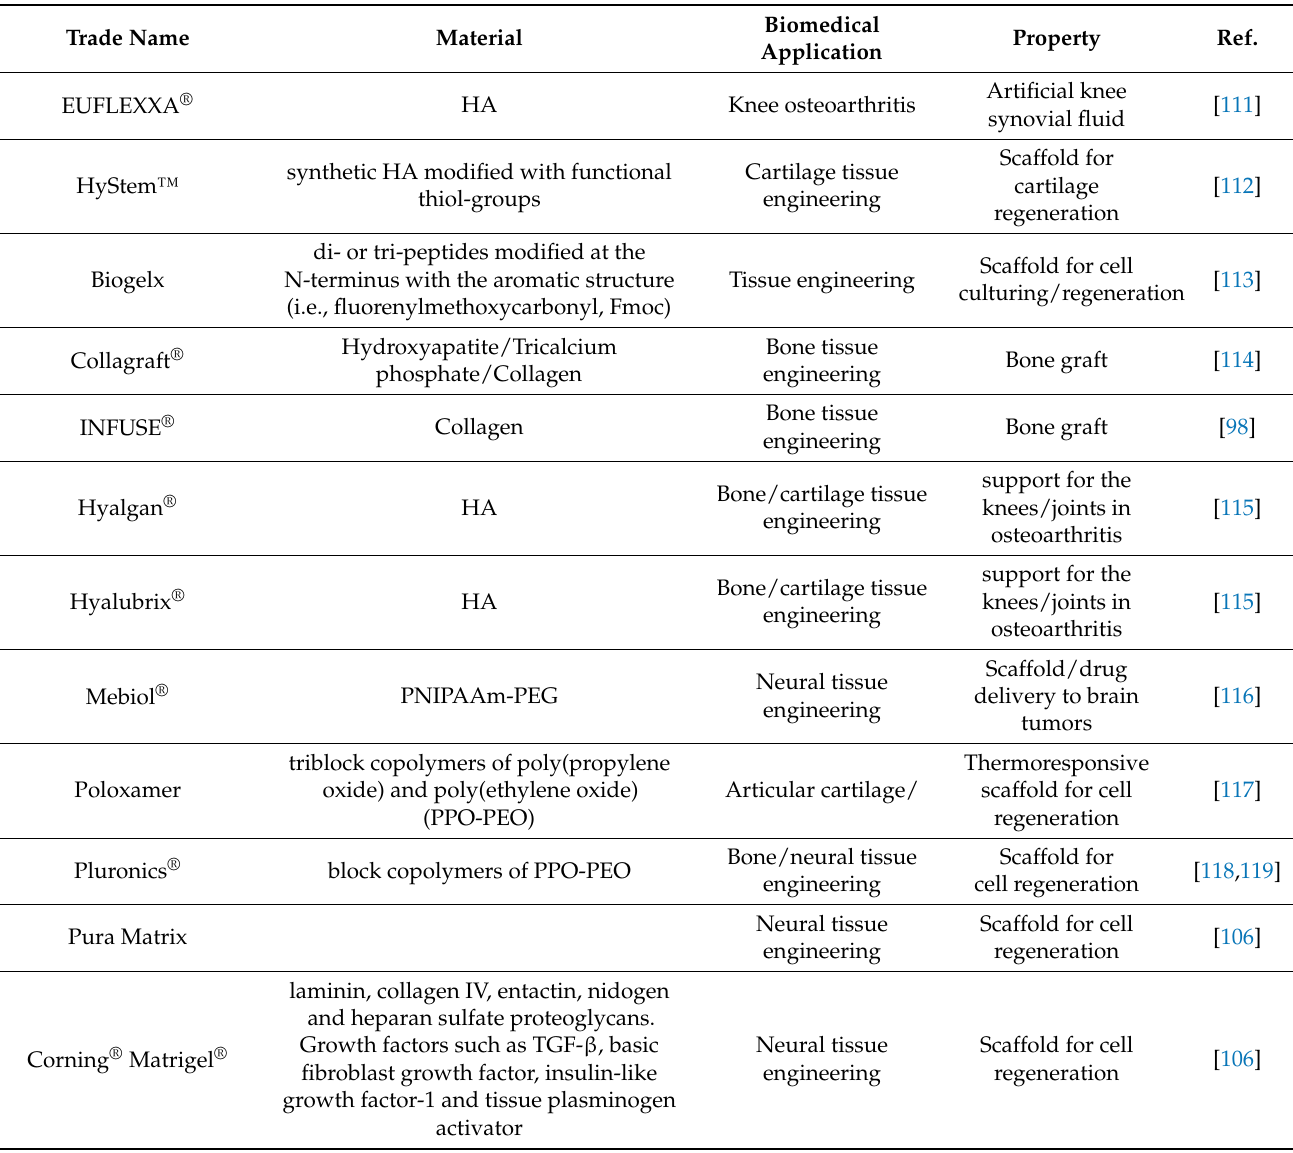
Table 1. List of commercially used hydrogels for tissue engineering